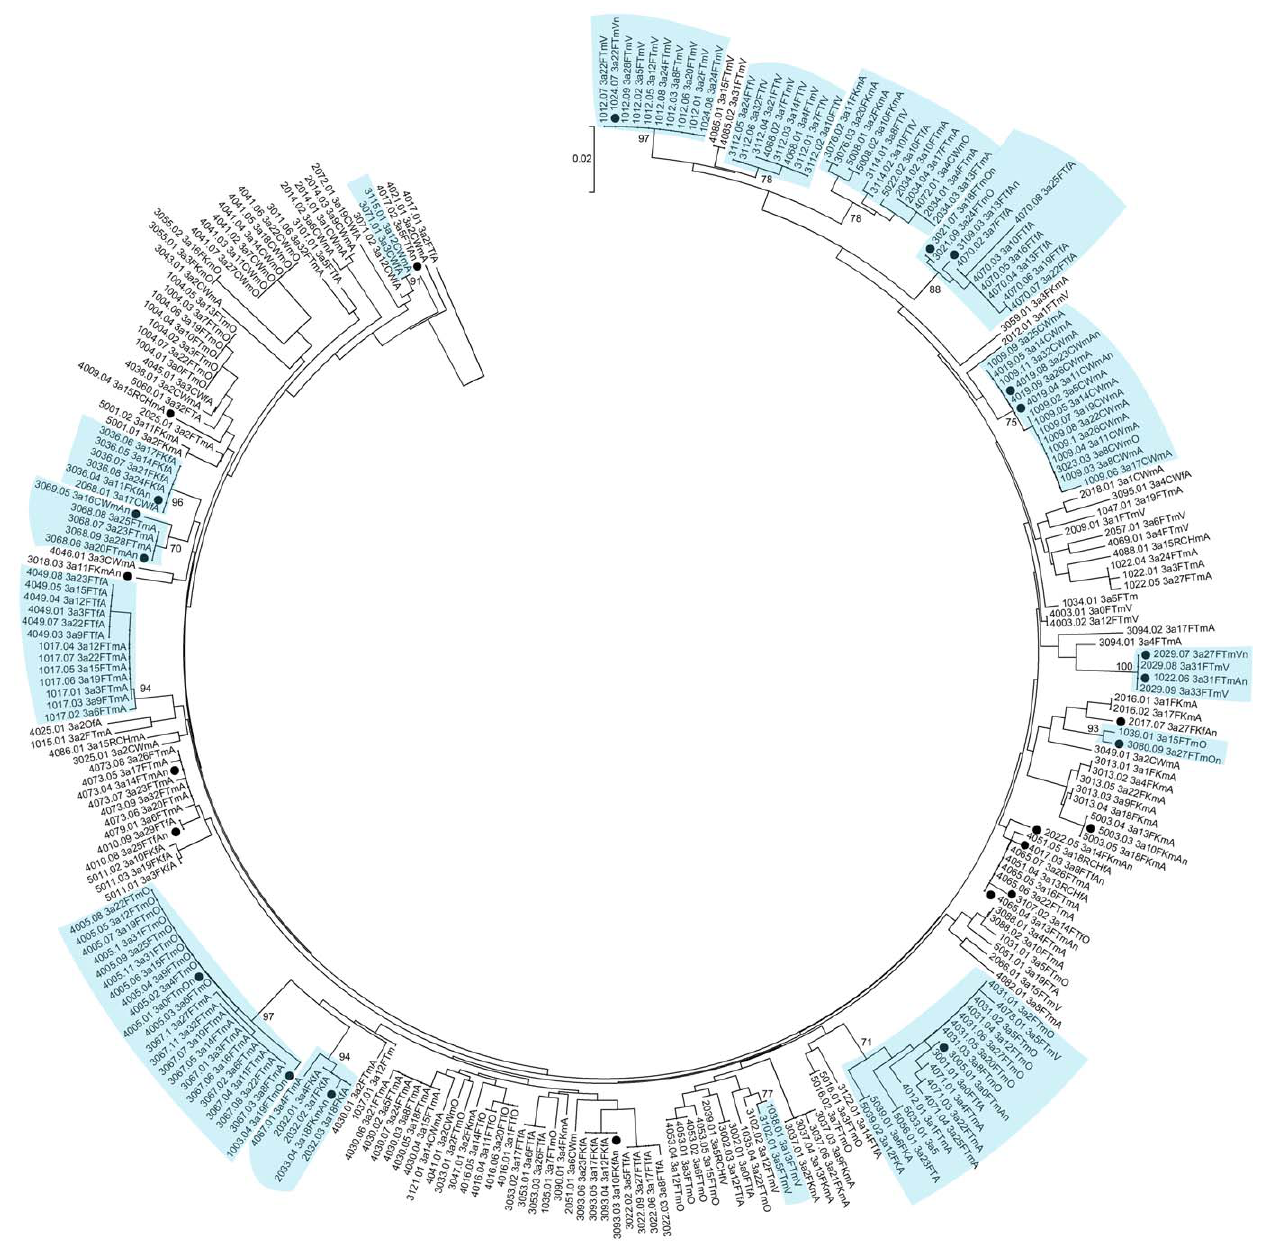
Figure 5. Neighbor-joining analysis of HCV genotype 3a core sequences. Phylogenetic clusters defined by bootstrap analysis (cut-off 70%) with infections from multiple individuals in the study are highlighted in blue and bootstrap values for these clusters are indicated. Newly acquired infections and changes in viral sequence are denoted using black-filled circles.